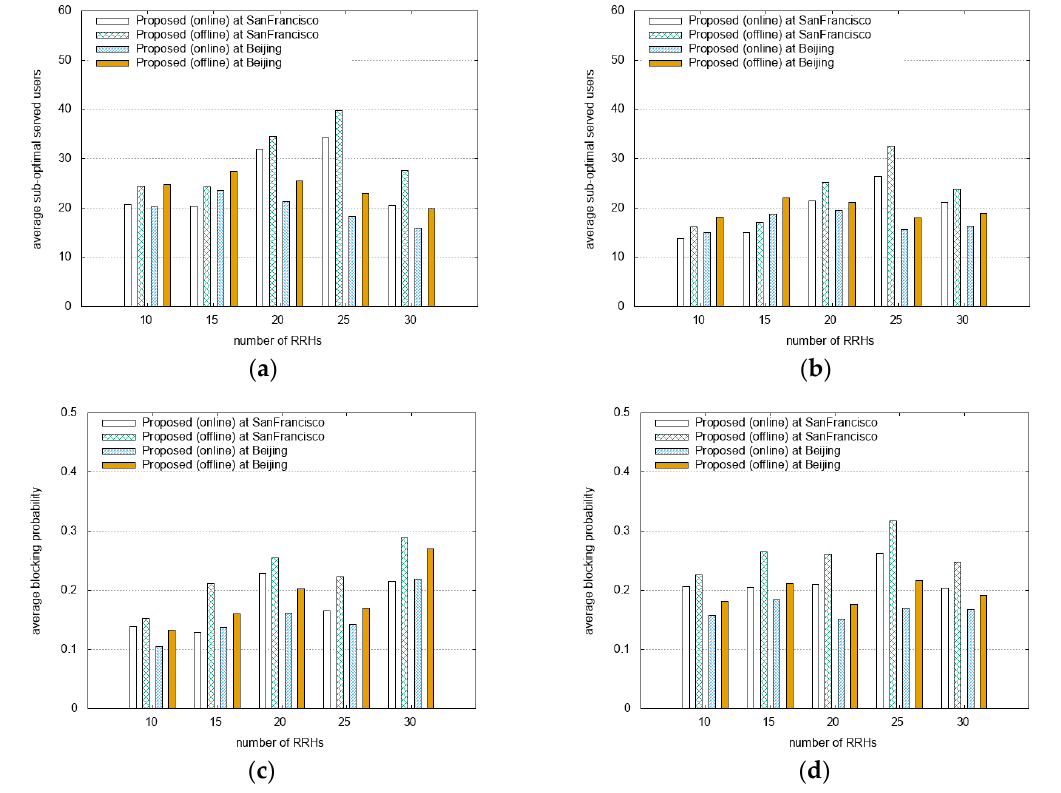
Figure 4. Comparison of the online and offline algorithm with 500 UEs. ( a ) The number of suboptimal served users with Gaussian distribution and ( b ) with uniform distribution; ( c ) blocking probability with Gaussian distribution and ( d ) with uniform distribution.